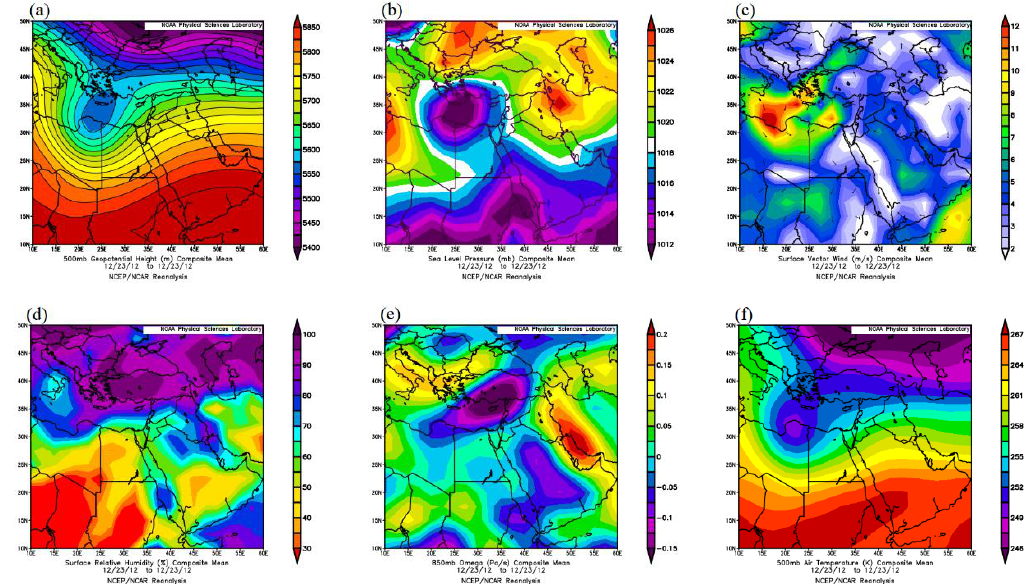
Figure 2: The weather chart for 23 December 2012, (a) 500 mb geopotential height (m), (b) sea level pressure (mb), (c) surface wind (m/s), (d) surface relative humidity (%),